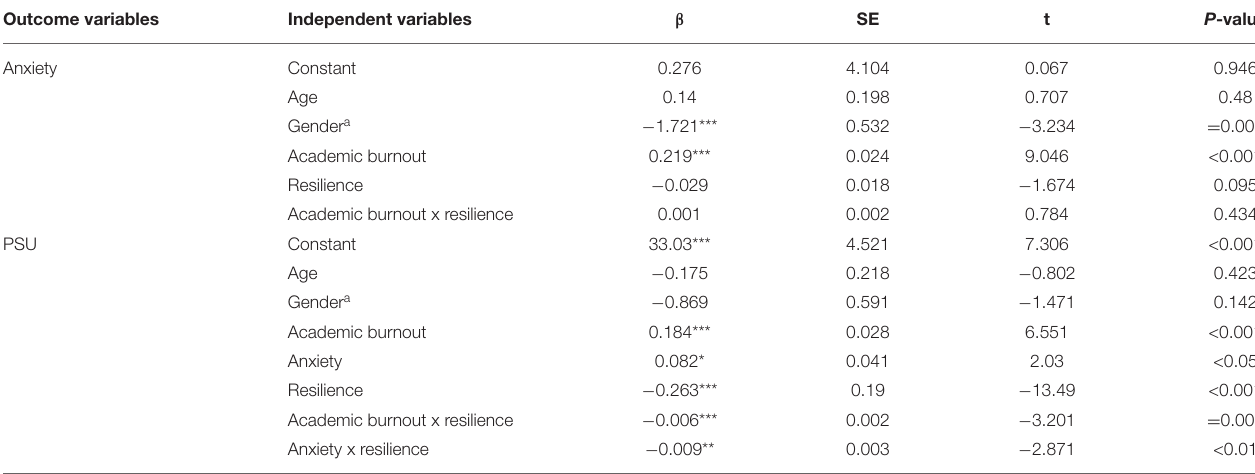
TABLE 4 | Moderated mediation analysis by model 59.